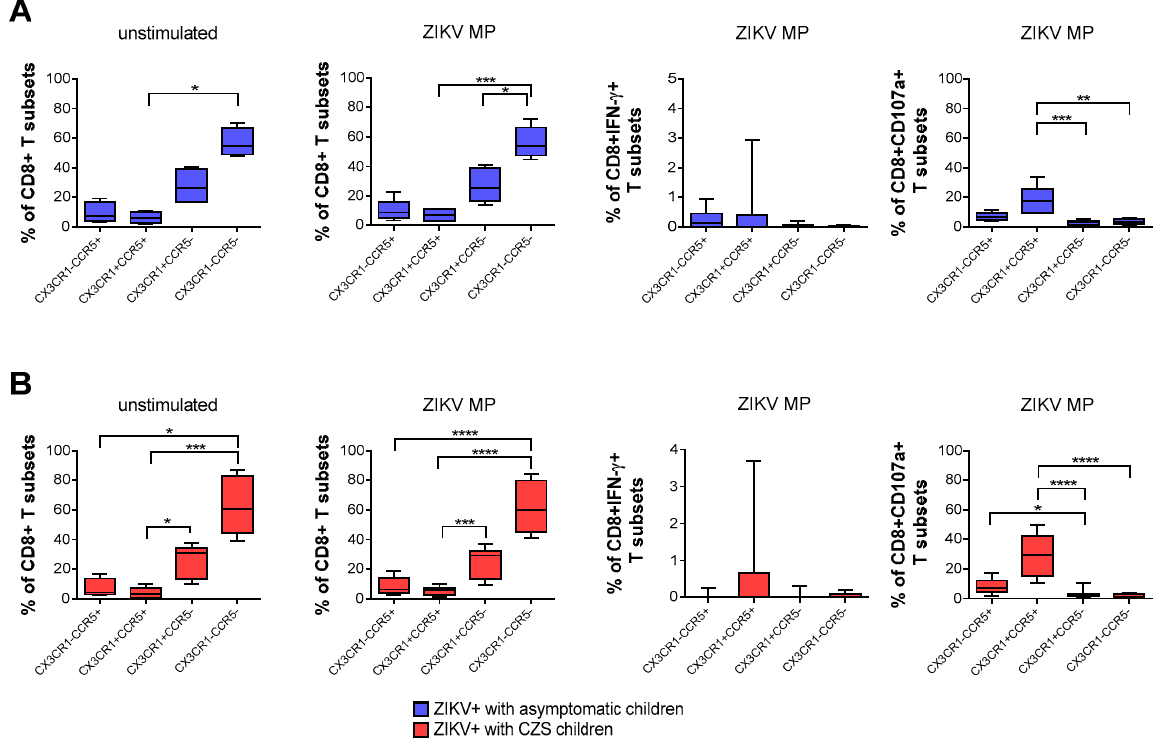
Figure 4. Expression of CCR5 and/or CX3CR1 correlated with the functionality of CD8 T cells of mothers with a history of ZIKV infection. Frequency of CD8+ T cells according to the expression of CCR5 and/or CX3CR1 in mothers who had asymptomatic babies (blue, n = 8–12) ( A ) and in those who had CZS children (red, n = 10) ( B ). Frequency observed after stimulation with ZIKV MP peptides in each group of mothers. The gates of IFN- γ -producing CD8+ T cells and CD8+CD107a+ were selected as an analysis strategy. Data are expressed as box and whiskers (min to max). Statistical analyses were performed using Friedman’s test followed by Dunn’s multiple comparisons test between the groups of mothers. Asterisks indicate significant differences (* p < 0.05, ** p < 0.01, *** p < 0.001, **** p < 0.0001).